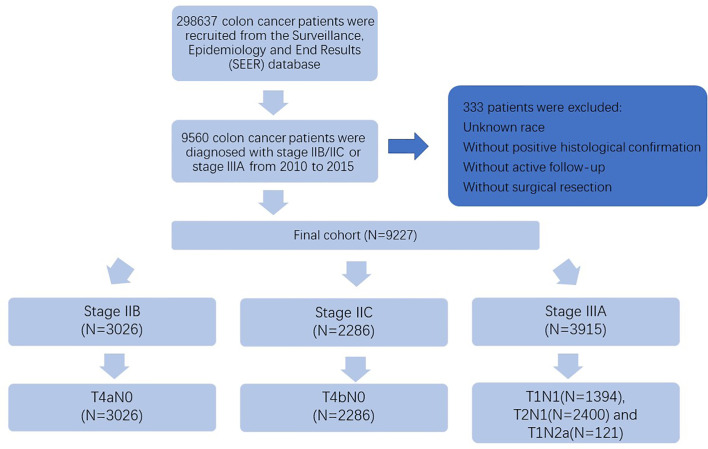
Flow diagram showed how eligible cases were selected from the SEER database.